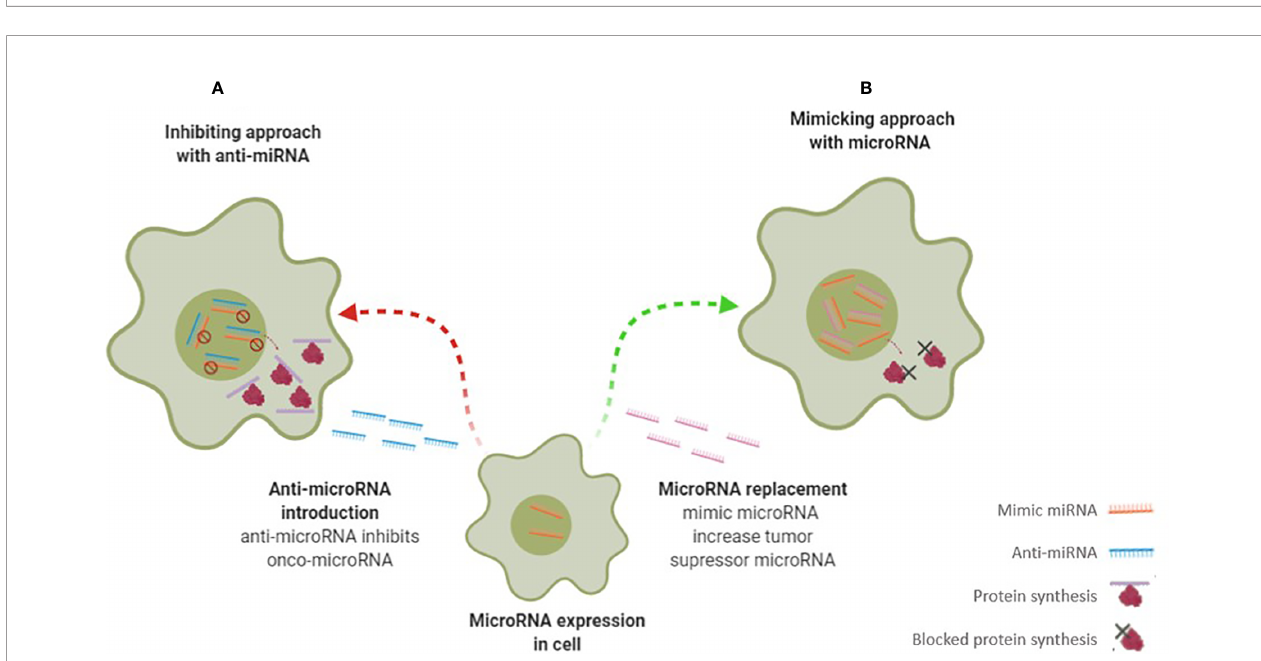
FIGURE 4 | Scheme illustrates different microRNA therapy approaches – anti-microRNA therapy (A) and mimicking microRNA therapy (B) to change miRNA- regulated gene expression. In therapy (A) the microRNA inhibitors are transfected to cells and suppressing onco-microRNA functions and consequently increased protein production. In contrast, in therapy (B) are introduced microRNA mimetics to target cells where interact with tumor suppressor microRNA target, suppressing of protein production.